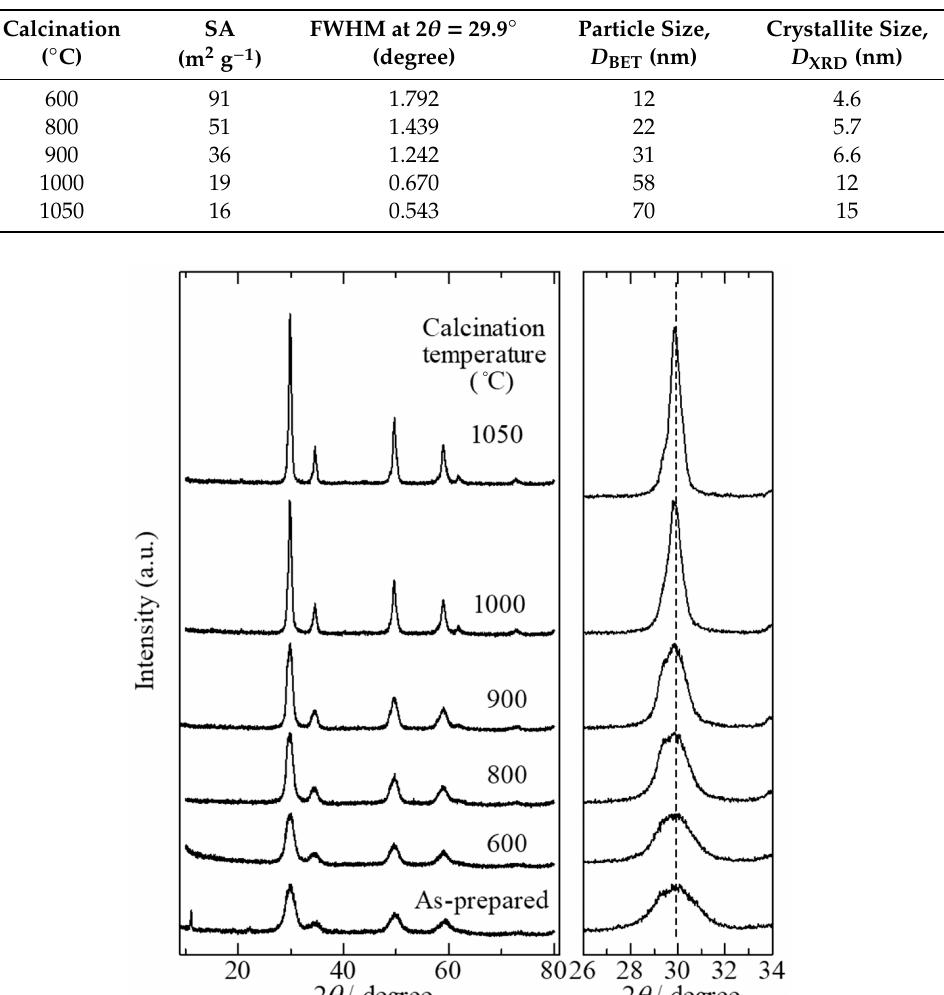
Table 4. Physical properties of YZrO calcined at di ff erent temperatures.